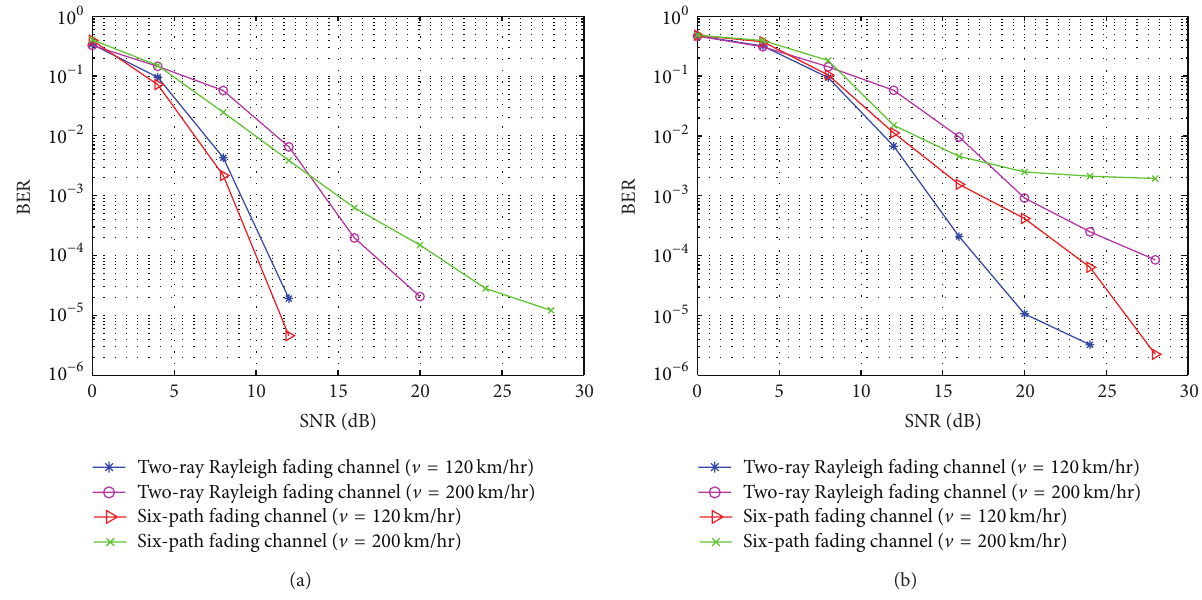
Figure 2: BER of the OFDM transceiver over two-ray Rayleigh fading channel and six-path fading channel with 13nsec delay spread for (a) 16-QAM and (b) 64-QAM.